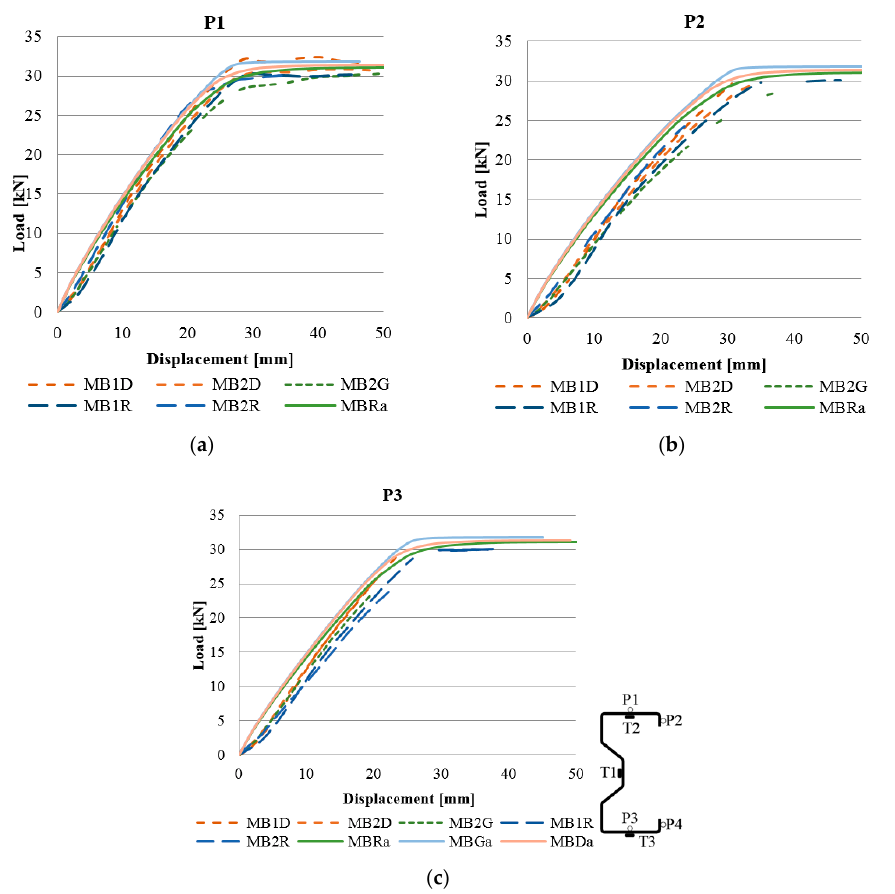
Figure 14. Load–displacement relationship in the vertical direction during laboratory tests and at the corresponding point in the FE model, for points: ( a ) P1, ( b ) P2, and ( c ) P3.